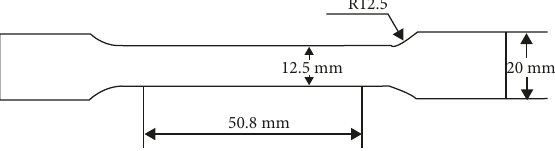
Figure 4: The ASTM B557M standard-tensile test.